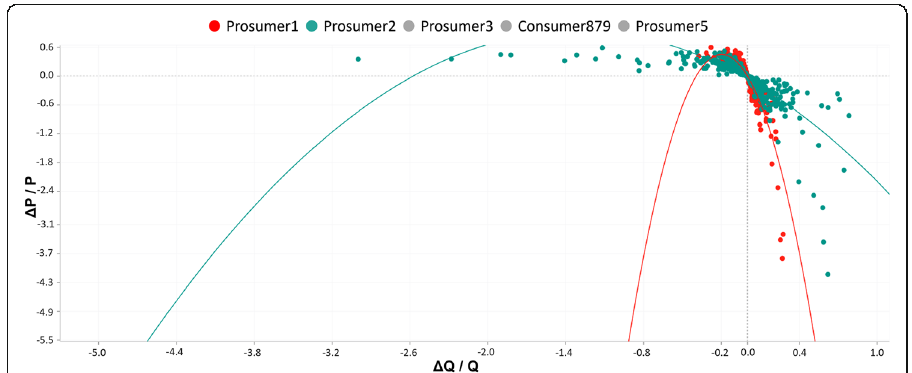
Fig. 11 Price elasticity graph